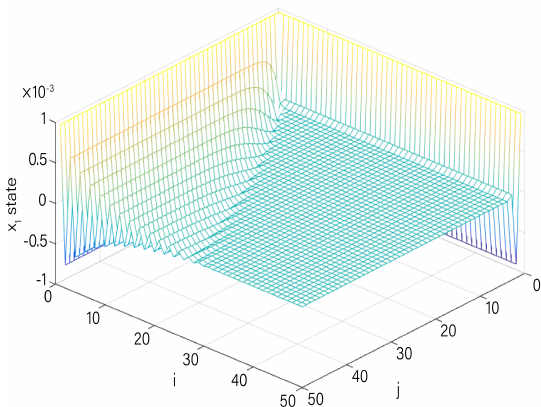
Figure 4. Closed-loop state space response of x 1 ( i , j ) when K = [0.01 0.08].